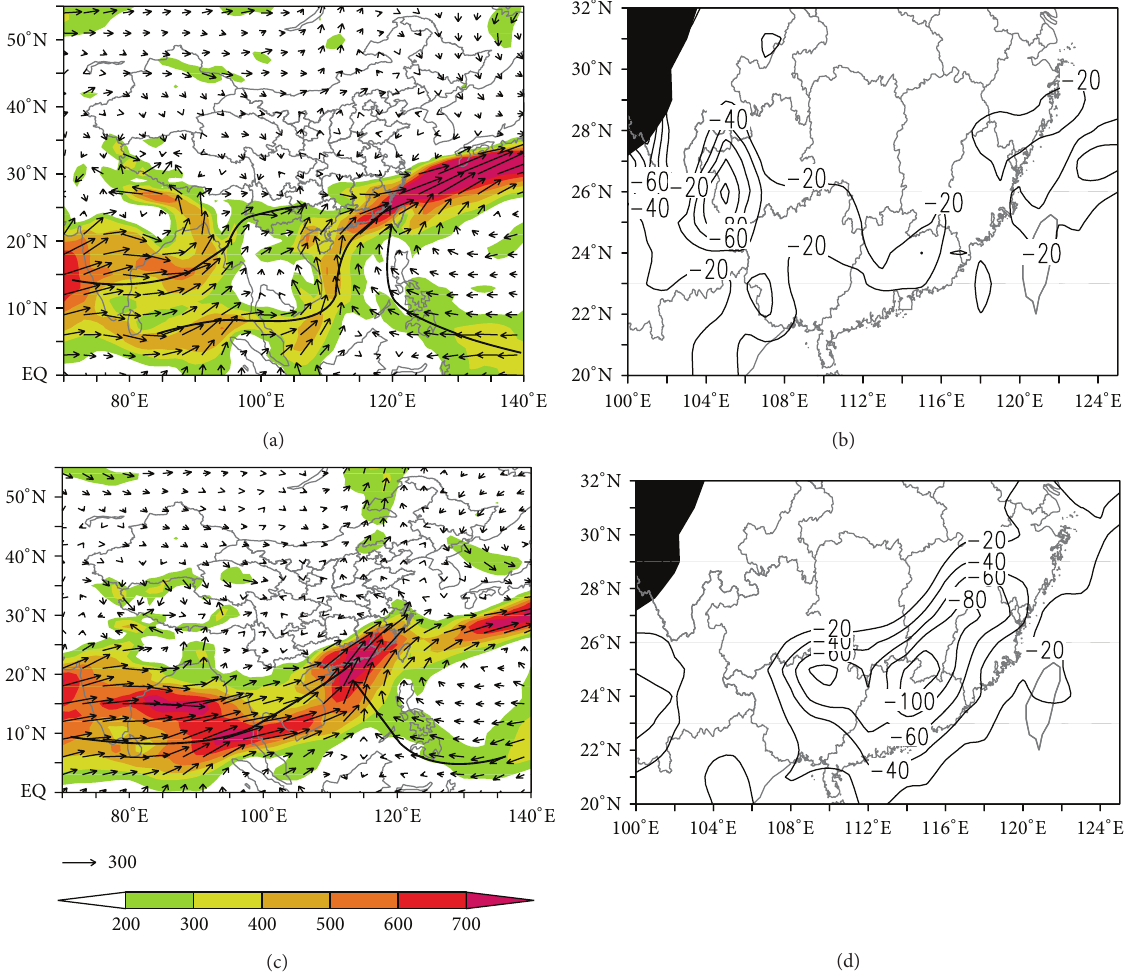
Figure 10: Distribution of water vapor transport flux vectors and strengths (color contours) integrated over 1000–300 hPa (kg ⋅ m −1 ⋅ s −1 ) (a) during 18 UTC of June 10–18 UTC of June 11, 2008, and (c) during 18 UTC of June 11–18 UTC of June 13, 2008, as well as (b and d) distribution of water vapor flux divergence ( × 10 −4 kg ⋅ m −2 ⋅ s −1